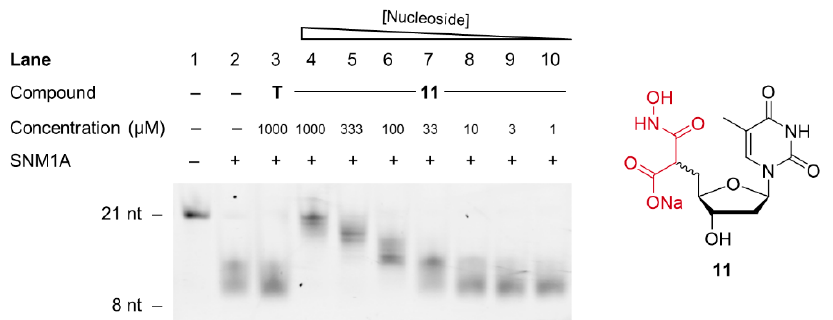
Figure 3. Concentration dependence of 5 ′ -C-linked malonate nucleoside 11 . Digestion of the phosphorylated oligonucleotide (80 nM) after incubation with SNM1A (2.5 nM) and nucleoside 11 (1000–1 µM) or thymidine ( T ) (1 mM) for 60 min at 37 °C, analysed by denaturing PAGE. SNM1A was preincubated with the modified nucleoside for 5 min at 37 °C prior to the addition of the substrate. nt = nucleotides. Table 1. Lowest concentrations at which inhibition was observed.